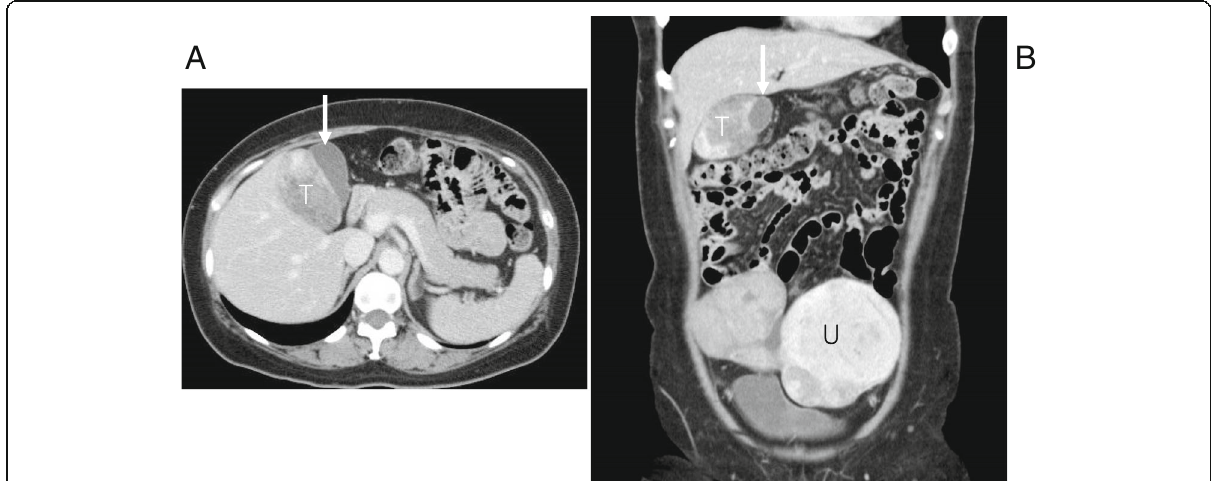
Fig. 1 a , b Dynamic computed tomography demonstrated a hypodense tumor (T) measuring approximately 7.0 cm in diameter beside the gallbladder (white arrow) apart from the uterine fibrosis (U)